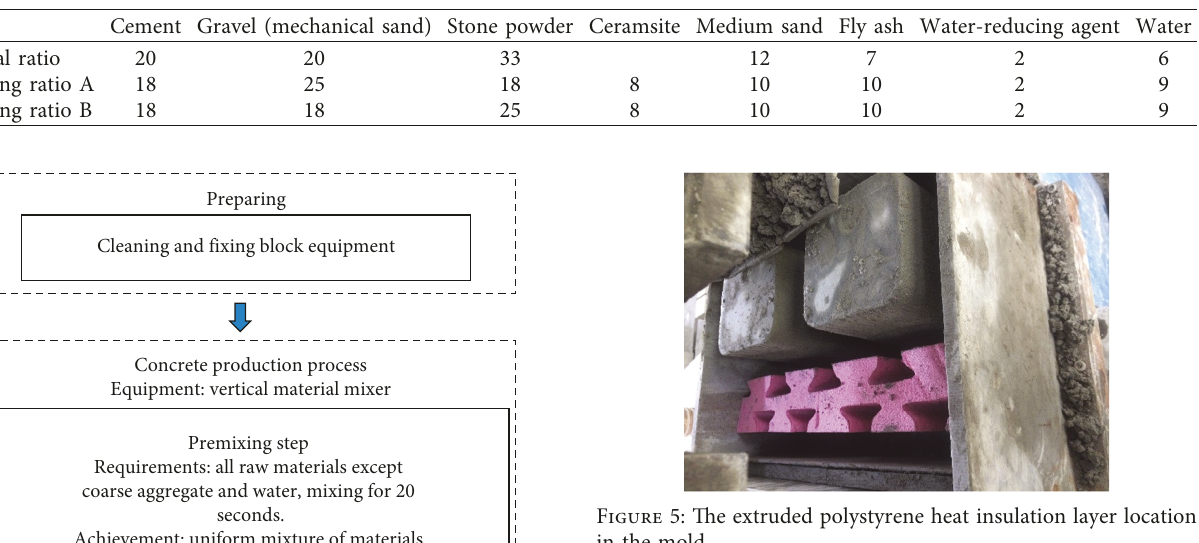
Table 2: Optimized A and B mixing ratios (%).